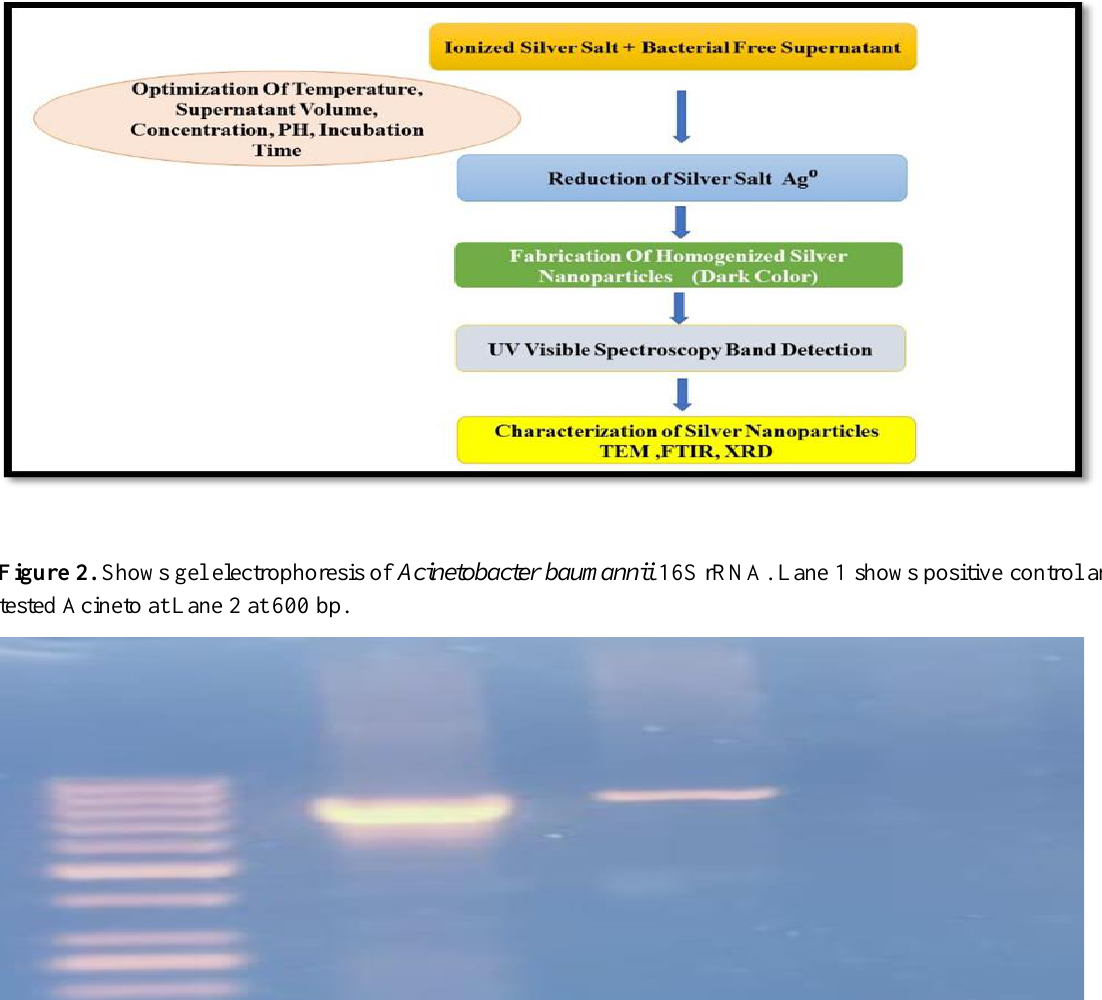
Figure 1. Diagram of biosynthesis method and characterization of silver nanoparticles.